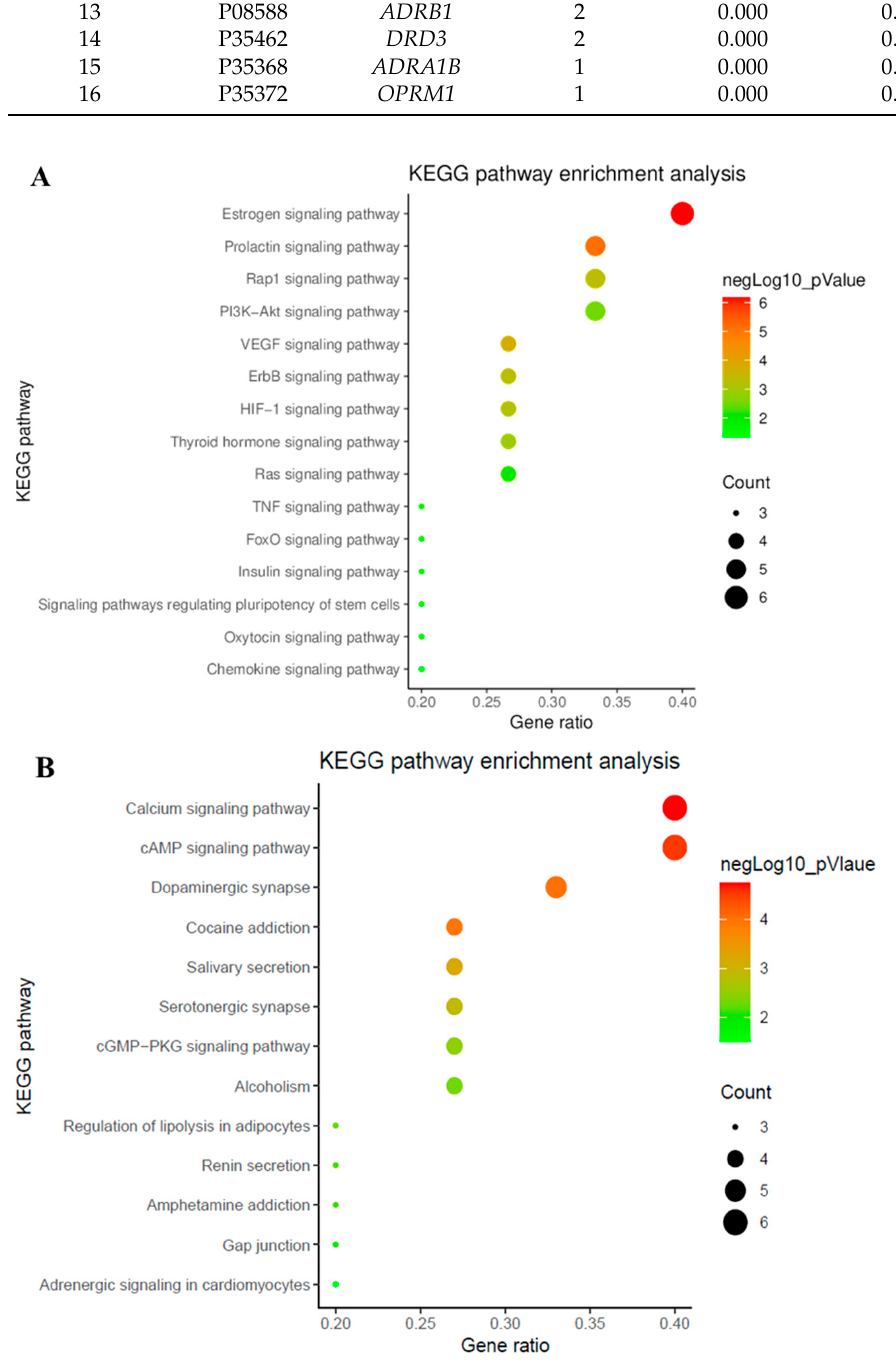
Figure 4. Bubble diagrams of the KEGG pathway enrichment analysis. ( A ) Bubble diagram visualizing KEGG pathway analysis of hispidulin anti-obesity key targets. ( B ) Bubble diagram visualizing KEGG pathway analysis of p -synephrine anti-obesity key targets.